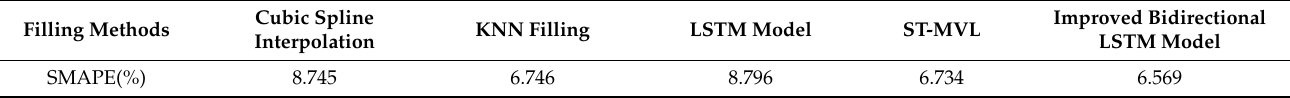
Table 8. Comparison of different filling